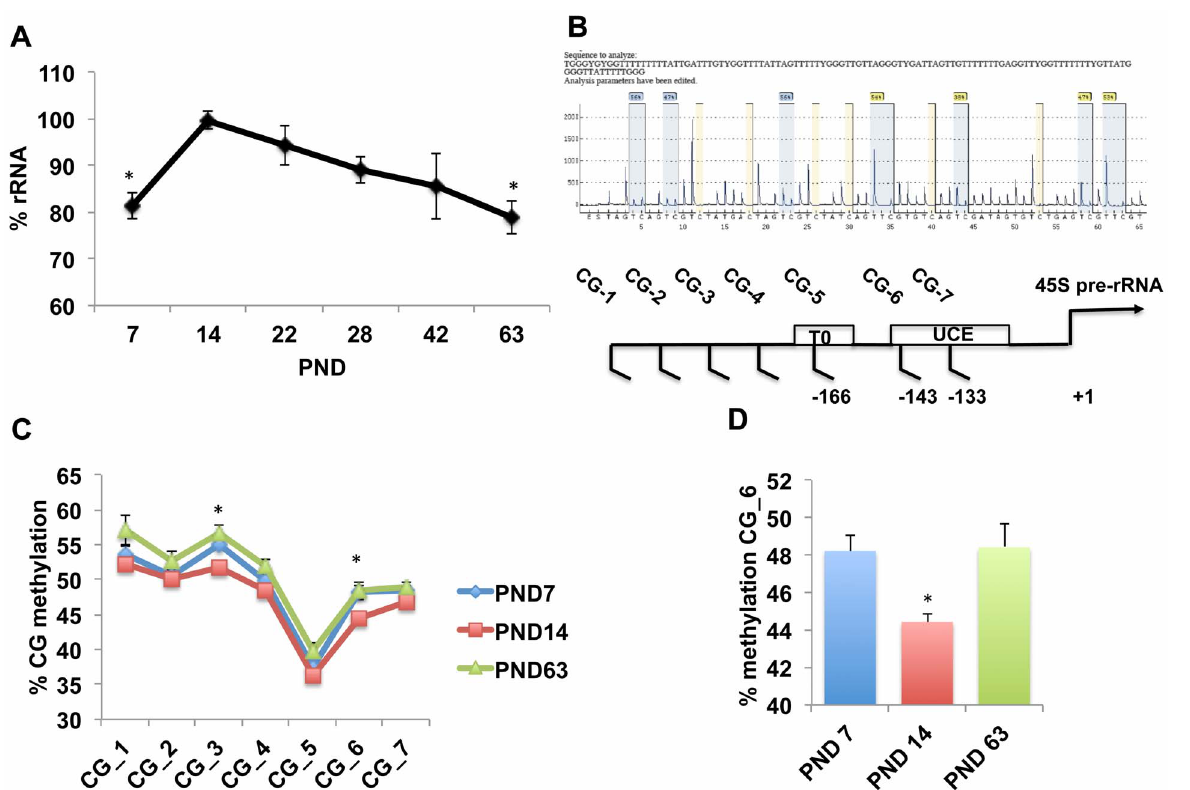
Fig. 2. rRNA levels in the hippocampus peak during the second week of life in a manner that is associated with reduced DNA methylation at the rDNA promoter. A. rRNA levels peak during the second week of life. B. (top), a representative pyrogram of the pyrosequencing assay used to assess DNA methylation (blue) lines, (bottom) schematic diagram of the rDNA promoter elements. C. DNA methylation at the rDNA is lower in PND14 compared to PND7 and PND63 for CG_3 and CG_6. D. DNA methylation levels at CG_6 on PND7, 14, and 63. One-way ANOVA followed by Tukey-post hoc analysis when compared to PND14 (A, D), repeated measures ANOVA followed by simple-effect analysis (C). Error bars represent mean ¡ SEM, *p , 0.05. UCE-upstream core element, To- Proximal-promoter terminator sequence.